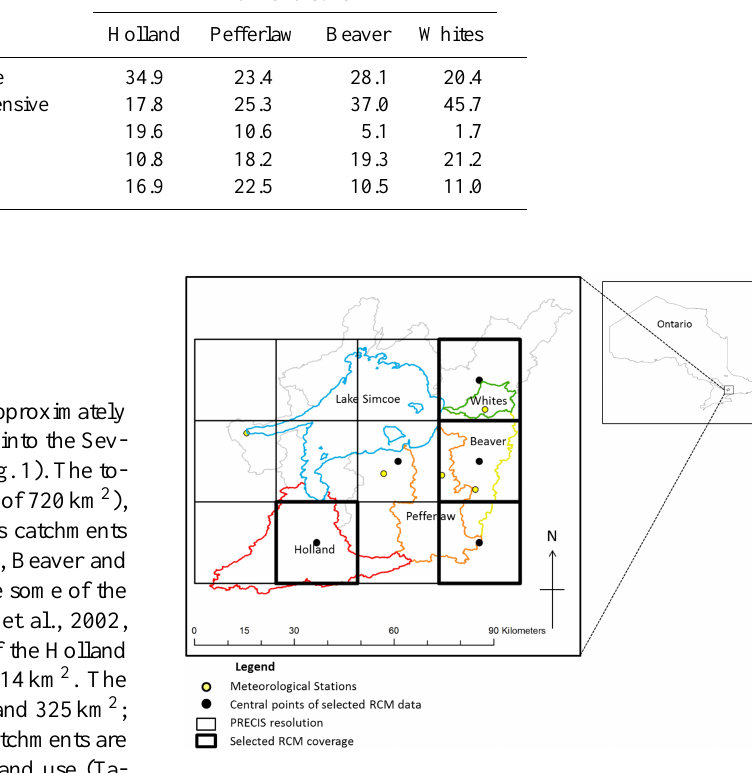
Figure 1. Map of 4 study catchments within the Simcoe Basin, southern Ontario, demonstrating PRECIS (Providing Regional Cli- mates for Impacts Studies) RCM (regional climate model), avail- able meteorological stations, and catchment